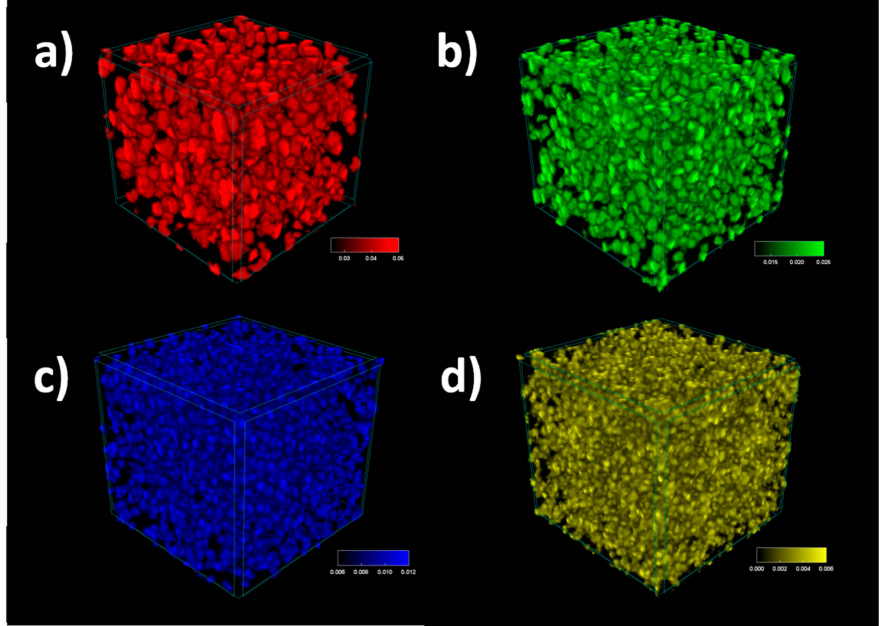
Figure 8. Pore distribution for specimen 300LB30, with the pore diameter of ( a ) d > 25 µ m, ( b ) 25 µ m > d > 12 µ m, ( c ) 12 µ m > d > 6 µ m and ( d ) d < 6 µ